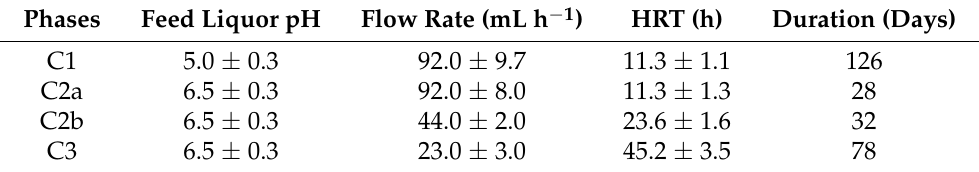
Table 1. Variations (average and standard deviation) in feed liquor pH, flow rates, HRT and duration of each phase of the MnOBs. In phase C3, the feed liquor pH was that pumped into the first